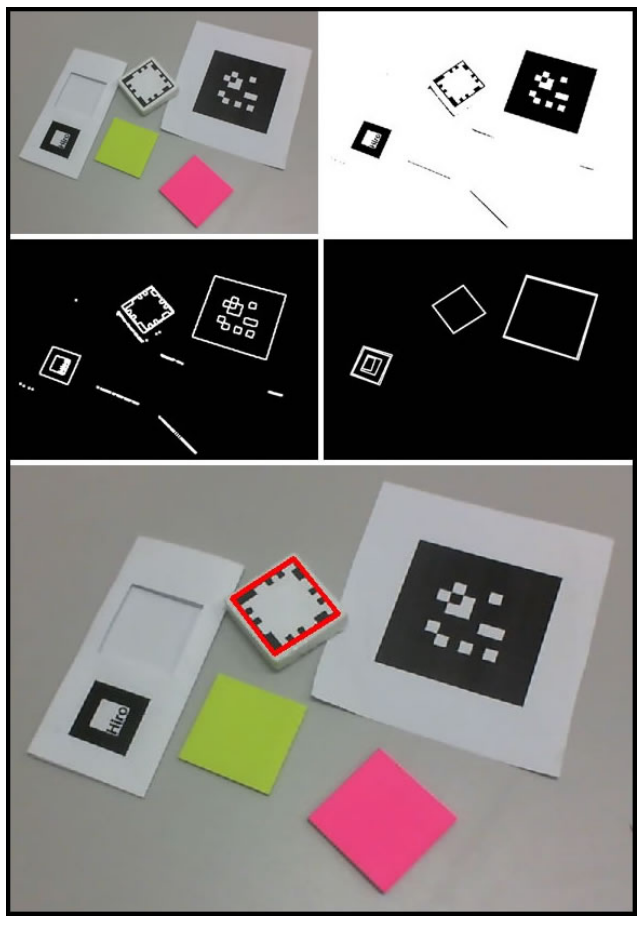
Fig. 6. The original frame captured by the camera appears on the top left of the image and on the top right there is the result from the segmentation process; the row in the middle shows every line extracted by the Canny and only the quadrilaterals that could be markers; in the end, only the proposed marker is selected.